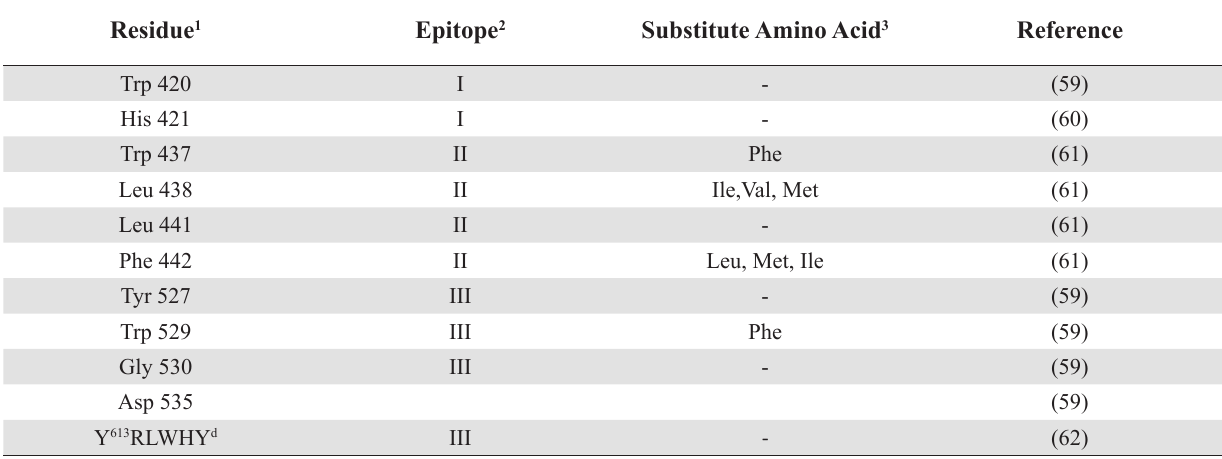
Table 1. Residues Involved in CD81 Binding Residue